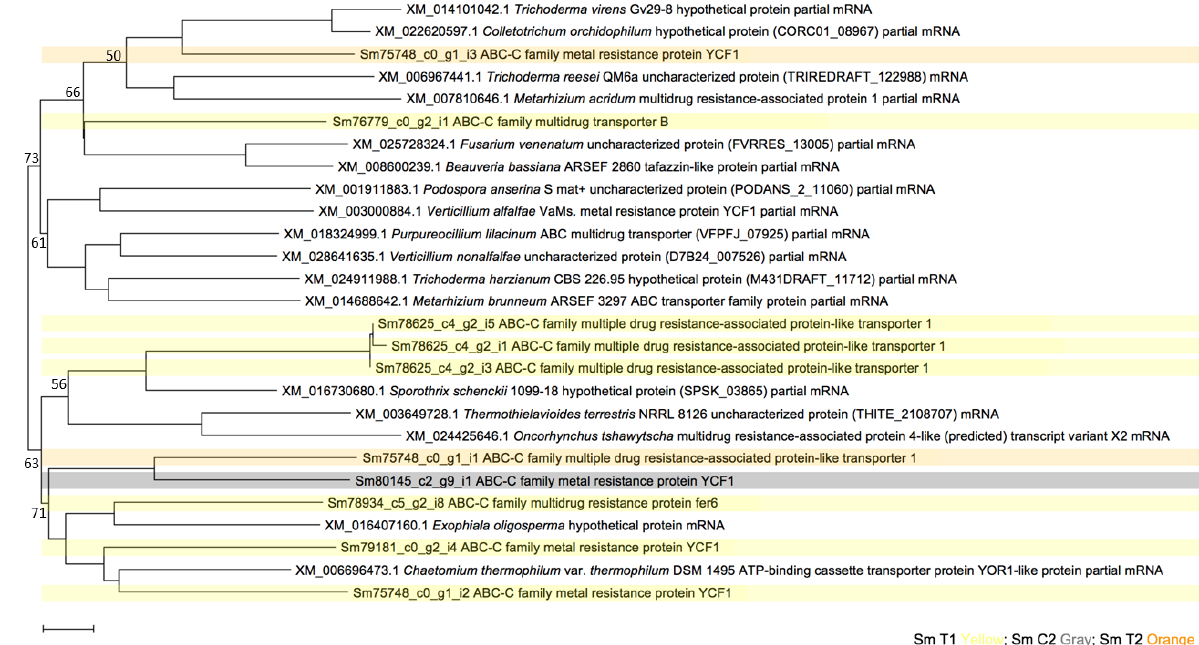
Figure 6. The unrooted phylogenetic tree for the ABC-C family transporters in S. mycoparasitica was built with MEGA-X by using the minimum evolution method [39]. The branch support bootstrap (>50%) values were obtained by 1000 replicates using the NJ method. Sm C2 (gray color) represents S. mycoparasitica incubated for 3.5 days without interaction with the host. Sm T1 (yellow color) and Sm T2 (orange color) represent S. mycoparasitica interacting with the host for respective incubation times (1.5 and 3.5 days).